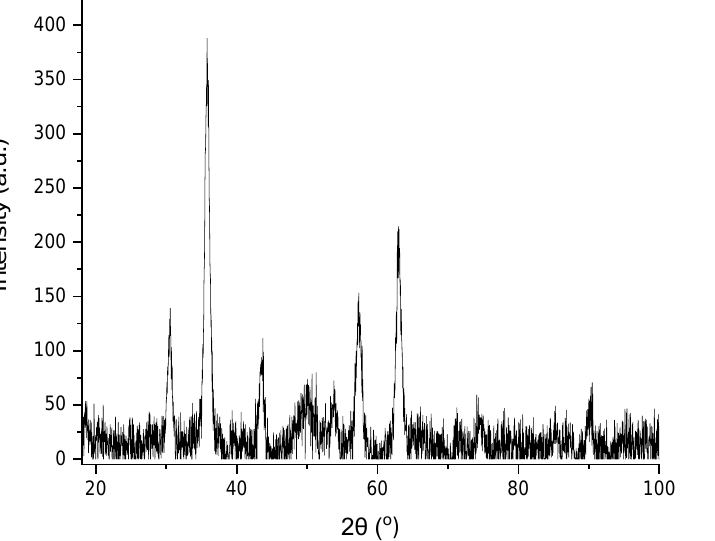
Figure 8. X-ray diffraction pattern of the magnetically functionalized electrospun fibrous adsorbent, denoting the presence of Fe 3 O 4 NPs.